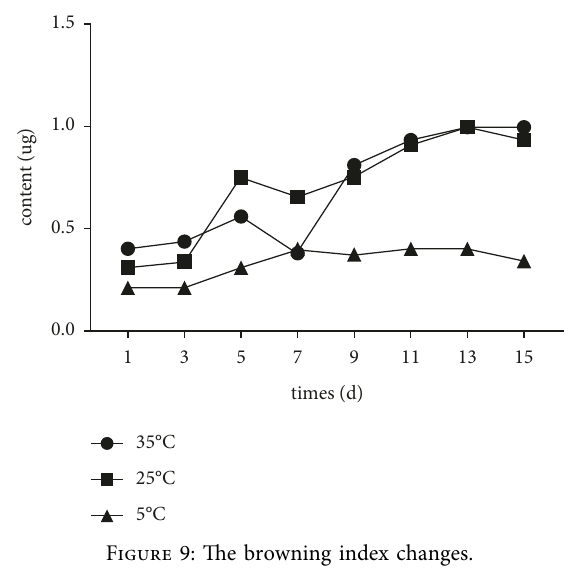
Figure 9: The browning index changes.